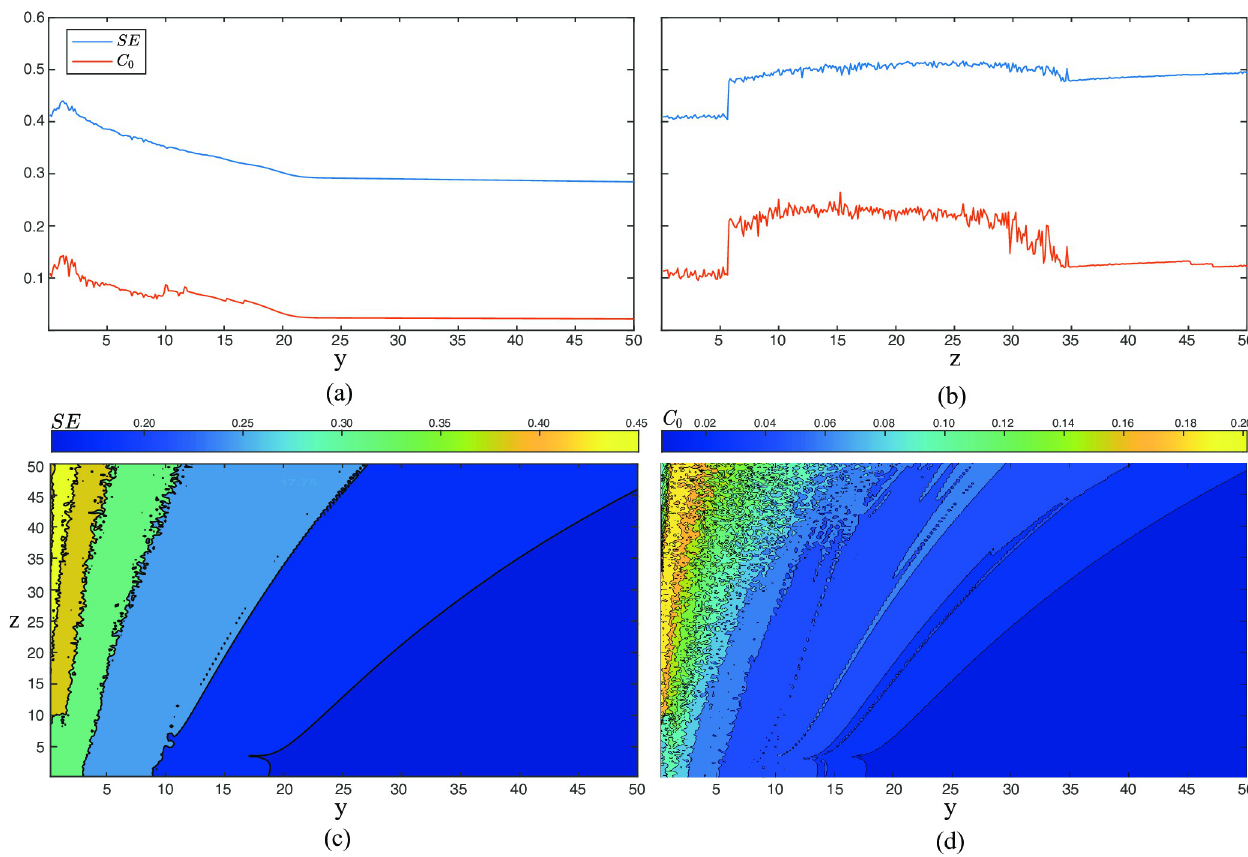
Fig 4. Variation of SE and C 0 as a function of the initial conditions of y and z . In all cases, SE and C 0 were computed from the variable x ( n ) and the parameters q = 0.99, ρ = 11, and ω = 1.5 were used. In the first two panels the values of initial conditions of (a) y and (b) z were ranged from 0 to 50, whereas in the two last panels contour plots for (c) SE, and (d) C 0 are shown.